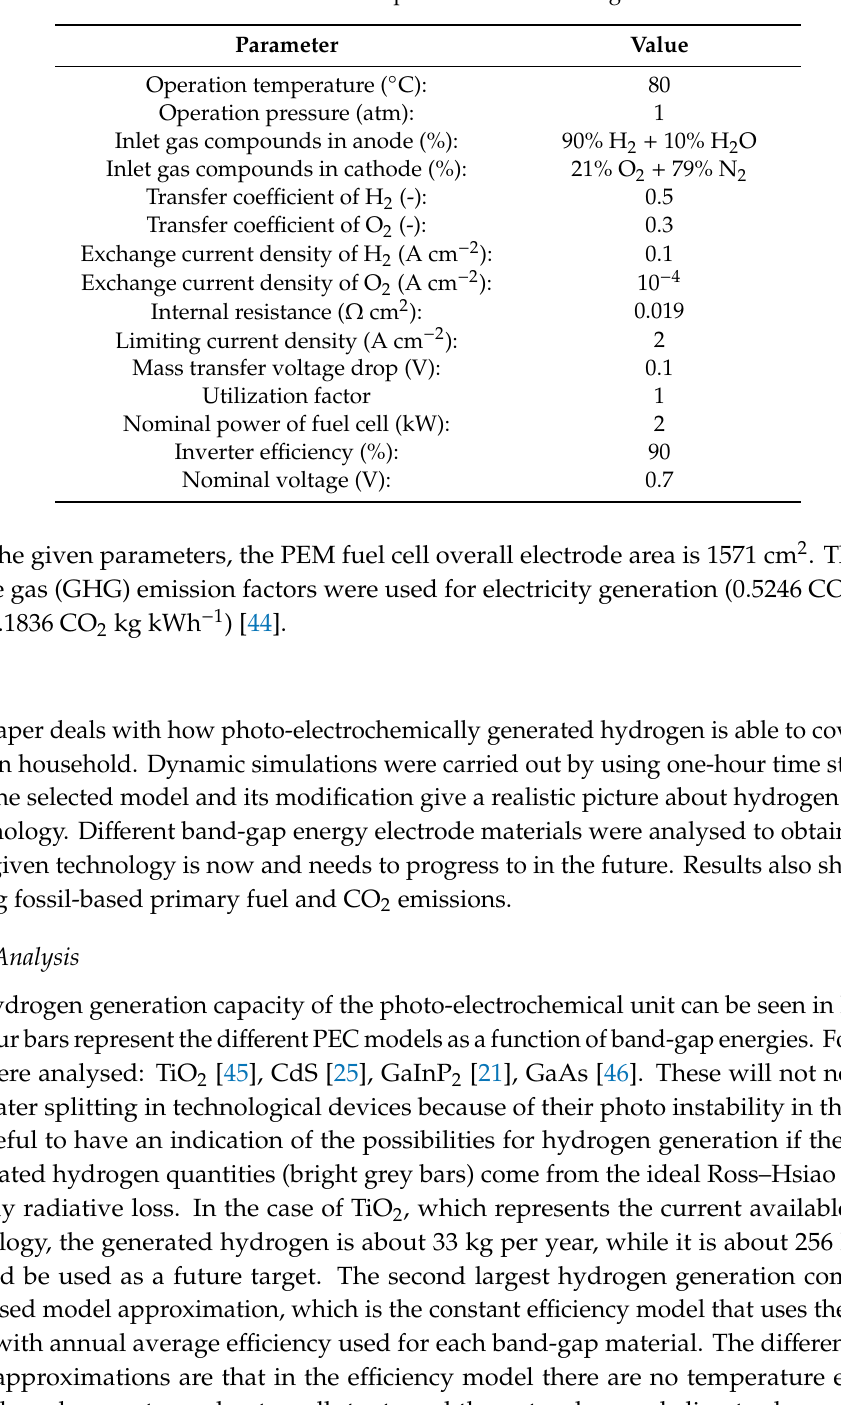
Table 4. Fuel cell parameters and